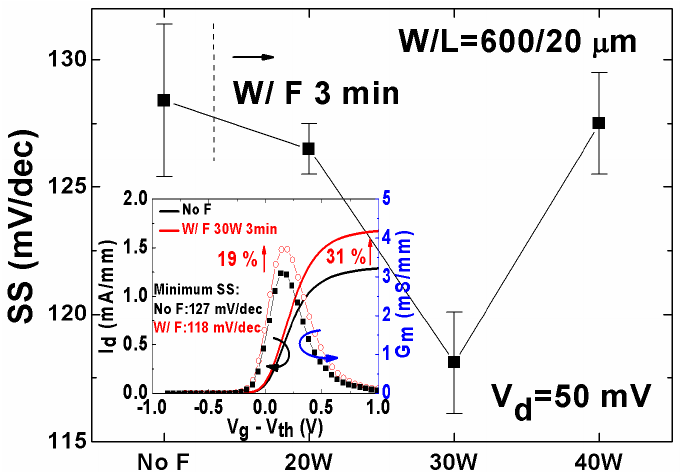
Figure 7. Subthreshold swing (SS) as a function of CF plasma treatment time: 3 min. Inset: I with CF /O plasma treatment for 30 W/3 4 2